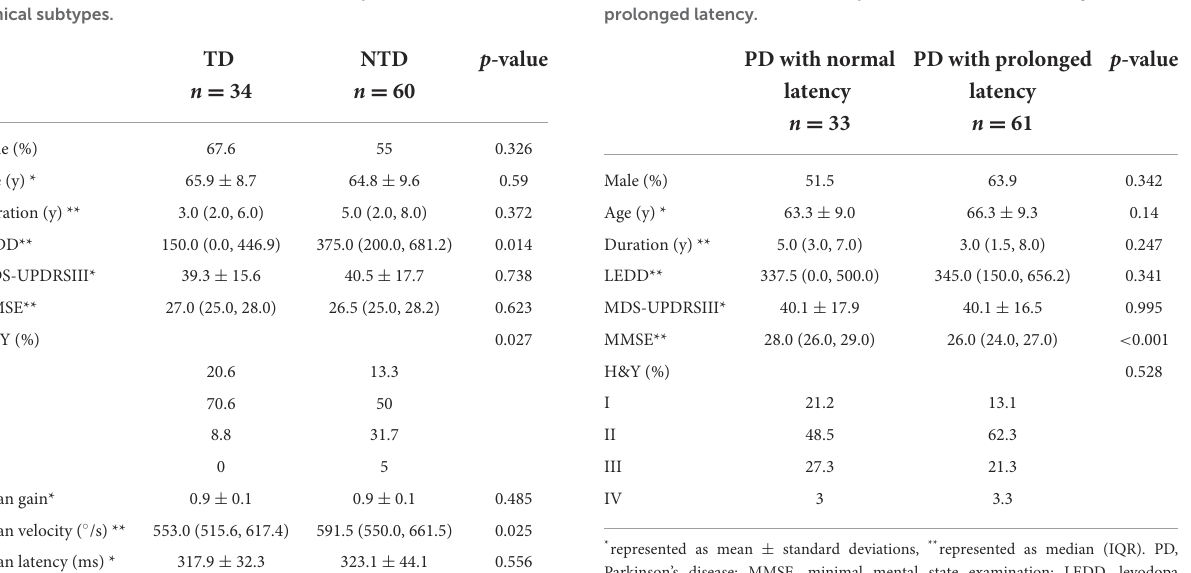
TABLE 3 Characteristics and reflexive saccadic parameters of PD clinical subtypes.